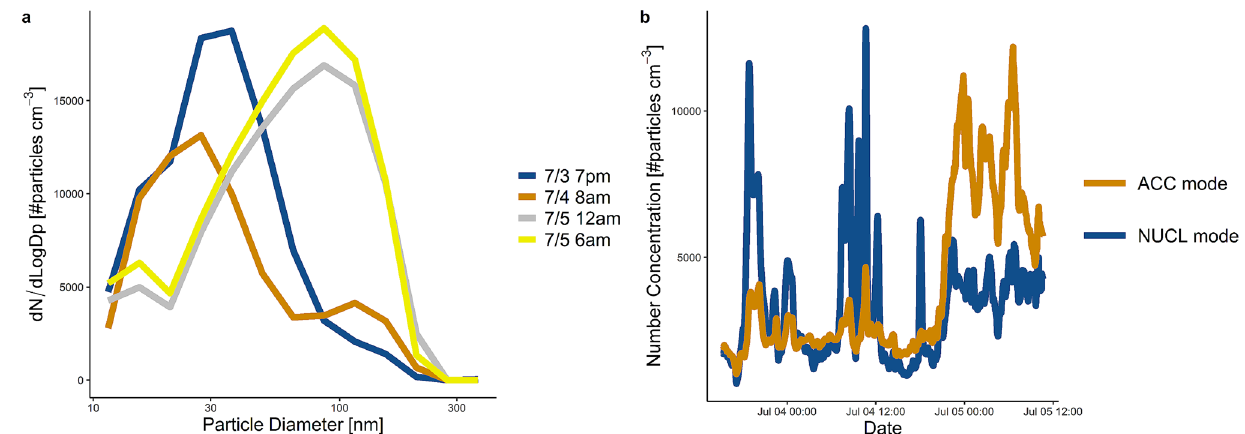
5th, and yellow line at 7 am on July 5th. b Number concentration in particles cm −3 classified in two different size ranges. Nucleation mode < 50 nm and accumulation mode > 50 and < 500